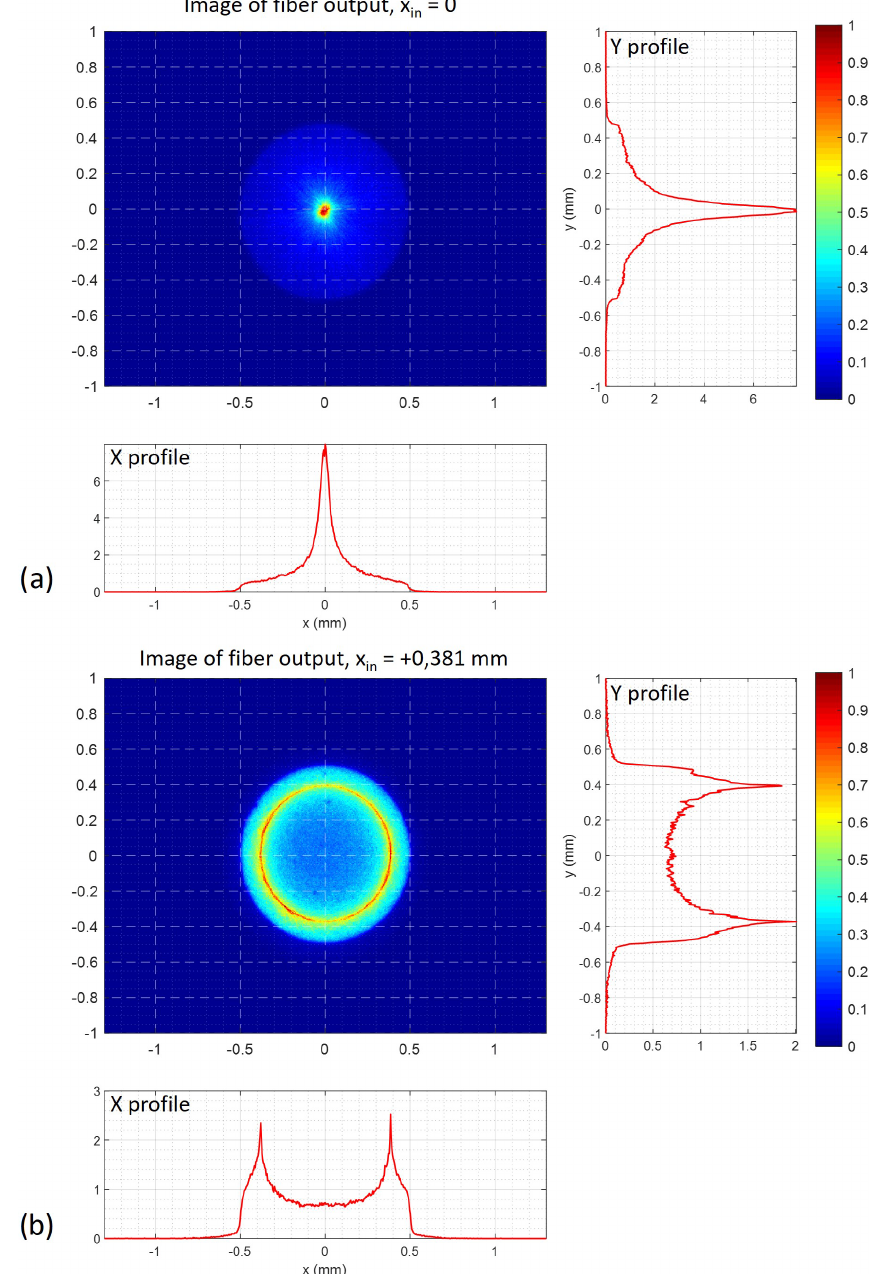
Figure 3. Images of the output facet of the 1mm diameter multimode fiber optics for (a) centered and (b) decentered (at x in = 0 . 38mm horizontal offset from the center of the core) input point of a 20mm beam focused on the input facet of the fiber and energy density profiles along the x and y